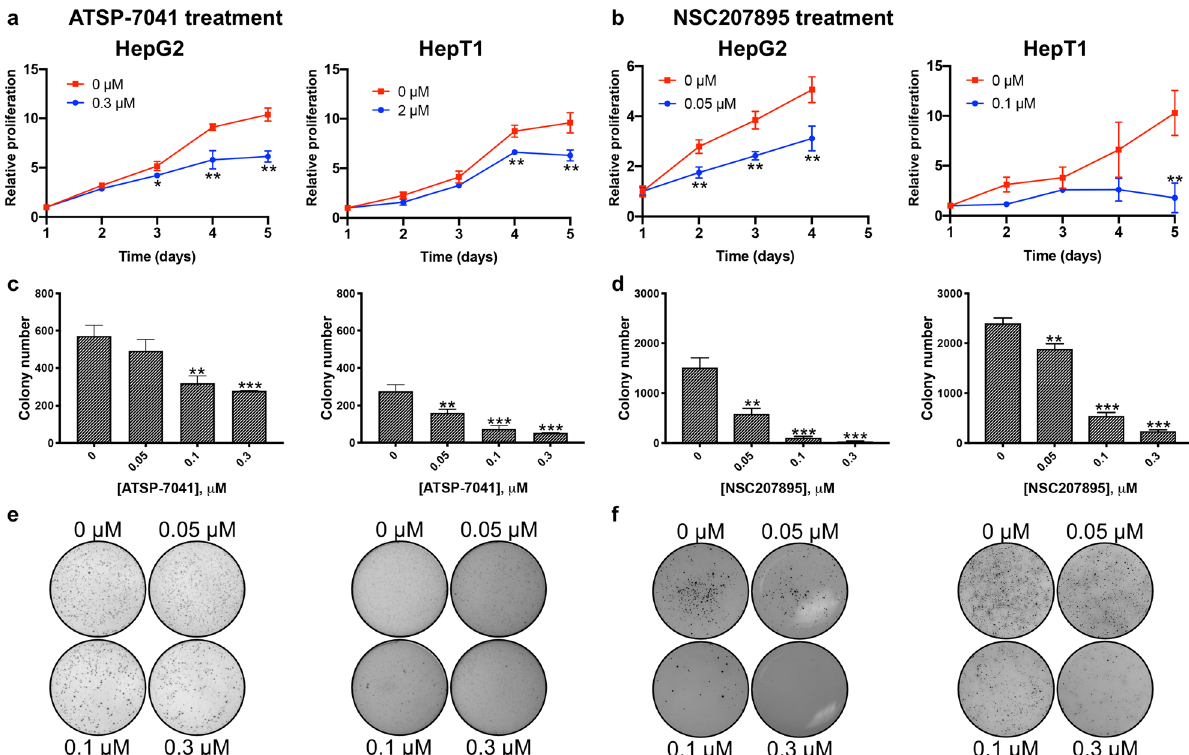
Figure 4. Inhibition of MDM4 leads to decreases in proliferation. ( a ) HepG2 and HepT1 cells were exposed to ATSP-7041 for 120 h and MTT assays were done at 24 h intervals to assess cell number. Data shown are representative of at least three independent experiments performed with three replicate wells each time. Error bars represent SD. Student’s t test * P < 0.05, ** P < 0.01, *** P < 0.001. ( b ) HepG2 and HepT1 cells were exposed to NSC207895 for 96 or 120 h and MTT assays were done at 24 h intervals to assess cell number. Data shown are representative of at least three independent experiments performed with three replicate wells each time. Error bars represent SD. Student’s t test * P < 0.05, ** P < 0.01, *** P < 0.001. ( c , e ) Cells were maintained in anchorage- independent conditions on a soft agar base with ATSP-7041 or vehicle for 2 to 3 weeks before staining with 500 μl of MTT solution for 4 h to visualize colonies. Images were captured by a VersaDoc Imaging System and colonies were counted with Quantity One software. Bar graphs in c represent colony numbers in indicated conditions. Data shown are representative of at least three independent experiments performed with three replicate wells each time. Error bars represent SD. Student’s t test * P < 0.05, ** P < 0.01, *** P < 0.001. ( d , f ) Cells were maintained in anchorage-independent conditions on a soft agar base with NSC207895 or vehicle for 2 to 3 weeks before staining with 500 μl of MTT solution for 4 h to visualize colonies. Images were captured by a VersaDoc Imaging System and colonies were counted with Quantity One software. Bar graphs in d represent colony numbers in indicated conditions. Data shown are representative of at least three independent experiments performed with three replicate wells each time. Error bars represent SD. Student’s t test * P < 0.05, ** P < 0.01, *** P < 48 h led to significant ( p < 0.001 ) changes in expression of Bax (1.47 fold change for HepG2, 1.8 fold change for HepT1), Puma (1.67 fold change for HepG2, 11.87 fold change for HepT1), CDKN1A (2.67 fold change for HepG2, 6.64 fold change for HepT1), and MDM2 (2.82 fold change for HepG2, 4.63 fold change for HepT1) at 0.5 μM (HepG2) and 2 μM (HepT1) concentrations of inhibitor (Fig. 5a). Similarly, exposure of HepG2 and HepT1 cells with low doses of NSC207895 (0.05–0.3 μM for HepG2, 1–3 μM for HepT1) for 48 h led to significant ( p < 0.01 ) changes in expression of Bax (1.49 fold change for HepG2, 1.38 fold change for HepT1), Puma (2.62 fold change for HepG2, 1.57 fold change for HepT1), CDKN1A (4.2 fold change for HepG2, 2.1 fold change for HepT1), and MDM2 (1.74 fold change for HepG2, 1.71 fold change for HepT1) at 0.1 μM (HepG2) and 1–2 μM (HepT1) concentrations of inhibitor (Fig. 5b). We then verified inhibition of MDM4 protein expression at these lower doses of NSC207895 for 48 h to show that effects on p53 signaling were occurring in an MDM4-dependent manner. Immunoblotting experiments with cells treated with 0.5 μM NSC207895 and ATSP-7041 for 48 h showed clear lower expression of MDM4 protein with NSC207895 treatment but not with ATSP-7041 treatment (Fig. 5c), which is expected since ATSP- 7041 does not affect expression levels of MDM4. We also examined induction of PARP and Caspase-3 cleavage at the same 0.5 μM dose of the drugs at 48 h to see if cell death was present under these conditions. With these experiments, we saw clear induction of PARP cleavage but no change in Caspase-3 cleavage (Fig. 5c), indicating